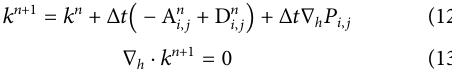
grid differential forms of500 × 500, 750 × 750, 1000 × 1000 were used according to the actual calculation needs. Grid size of1 × 10 − 6 m( dx (cid:1) dy ; dt (cid:1) dx 2 /5 D L ). The magnitude of